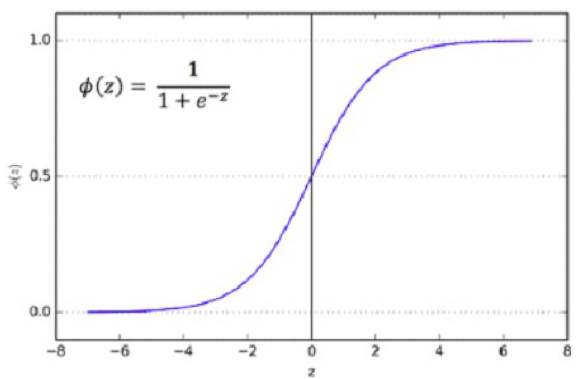
Figure 9. The Sigmoid curve at any two